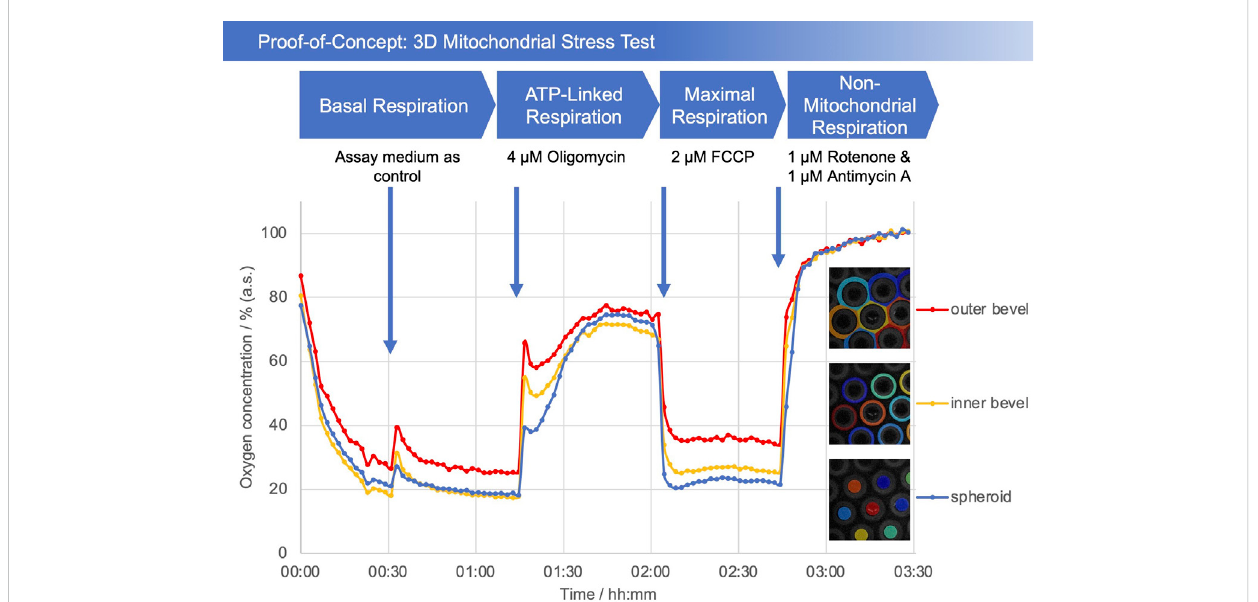
FIGURE 4 Plot of oxygen concentration in the sensor array (average of the number of the detected microcavities) during the mitochondrial stress test. 4 μ M oligomycin, 2 µM FCCP, and 1 µM of rotenone and antimycin A, respectively, were added. The oxygen valuesare measured with open cavities, no closed microcompartment is formed and oxygen is not consumed during the measurement process. The respective spheroid in its cavity generates an oxygen (post) diffusion equilibrium with the medium, thus is in a stress-free state under optimal cultivation conditions. Closed microcompartments, on the other hand, induce temporary hypoxic (stress) situations by cutting off oxygen post-diffusion (e.g., OCR measurements Seahorse/Agilent), even the measurement process itself can result in hypoxia when polarographic sensors (electrodes) are used. Methodically or sensorically induced hypoxia is avoided with the new method, furthermore hyperoxic situations can be detected by online monitoring and controlled, e.g., via incubator gassing changes. The overall outcome is that the spheroid can be cultured stress-free and physioxically, so that the mitochondrial stress caused by the test compounds can be optimally quanti fi